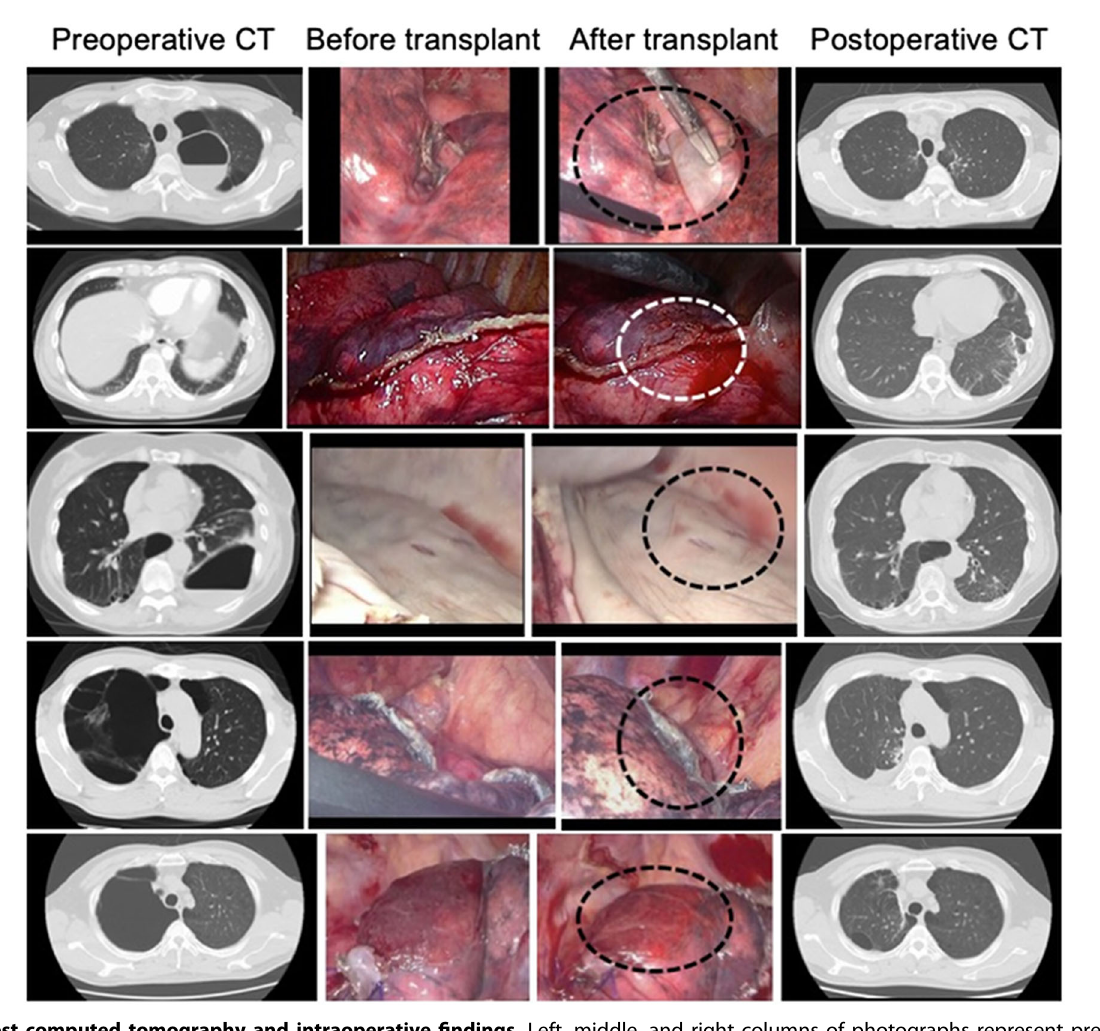
Fig. 3 Chest computed tomography and intraoperative fi ndings. Left, middle, and right columns of photographs represent preoperative chest computed tomography (CT), before fi broblast sheet transplantation from intraoperative digital video data, after fi broblast sheet transplantation from intraoperative digital video data, and postoperative chest CT, respectively. From case 1 to case 5 in this order from the upper row. The area of air leaks is surrounded by dashed lines in the middle